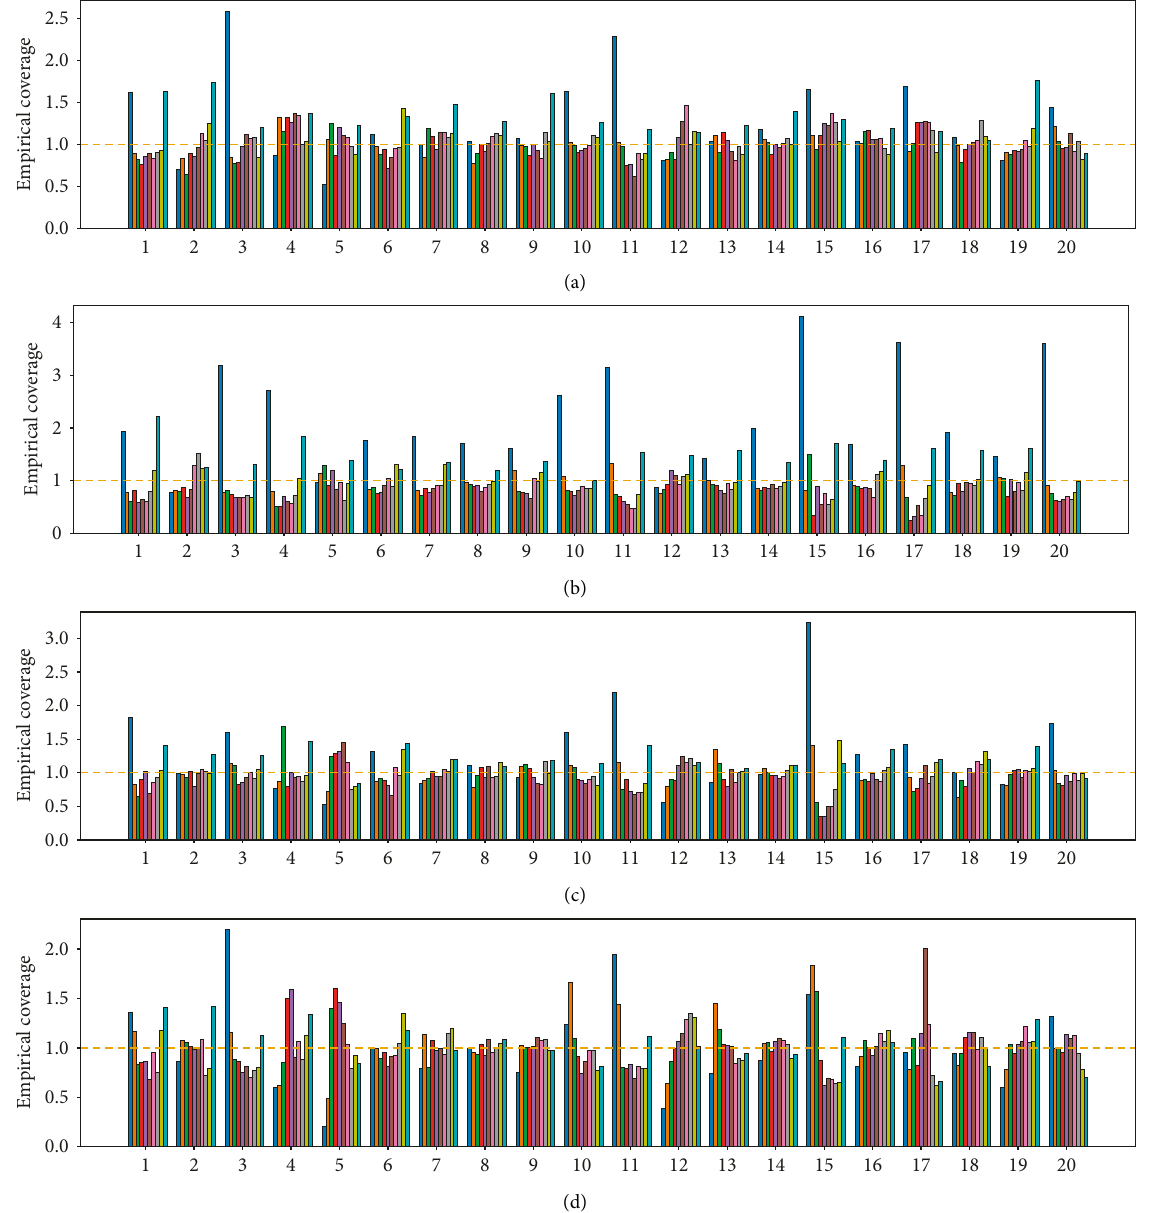
Figure 11: The empirical coverage of (a) QGBRT, (b) QCNN, (c) QLSTM, and (d) our proposed model. Y -axis denotes normalized empirical coverage and X -axis represents different residences with 10 bars individually corresponding to 10 intervals. A bar with height close to 1 indicates a better empirical